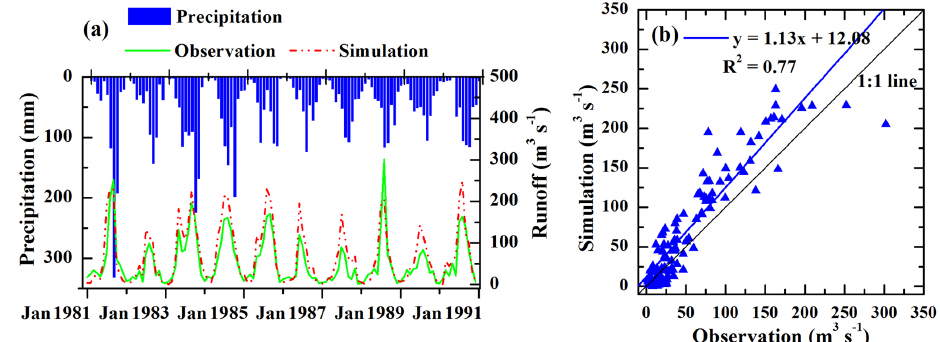
Figure 7. Comparison of observed and simulated runoff at the monthly scale in the Jinghe River basin during the validation period from 1981 to 1990. Panel (b) is redrawn from Qiu et al. (2011).